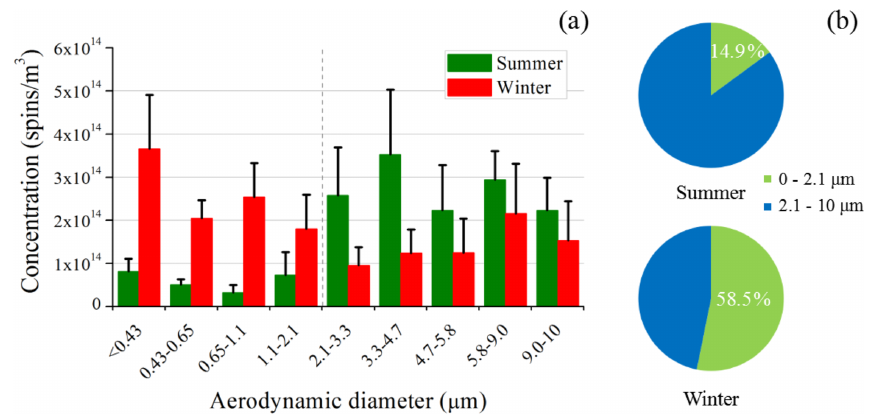
Figure 1. The concentration of EPFRs in PM with different particle sizes. (a) Atmospheric concentrations of EPFRs in different particle sizes in summer and winter. (b) The relative contribution of fine particles and coarse particles to the total EPFR